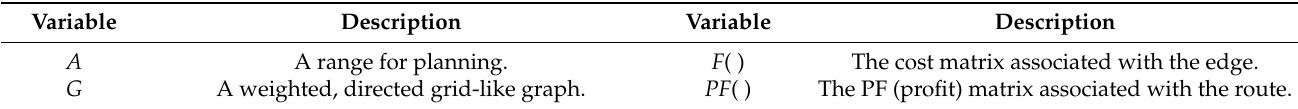
Table 1. Description for variables defined in the problem formulation. Variable Description Variable